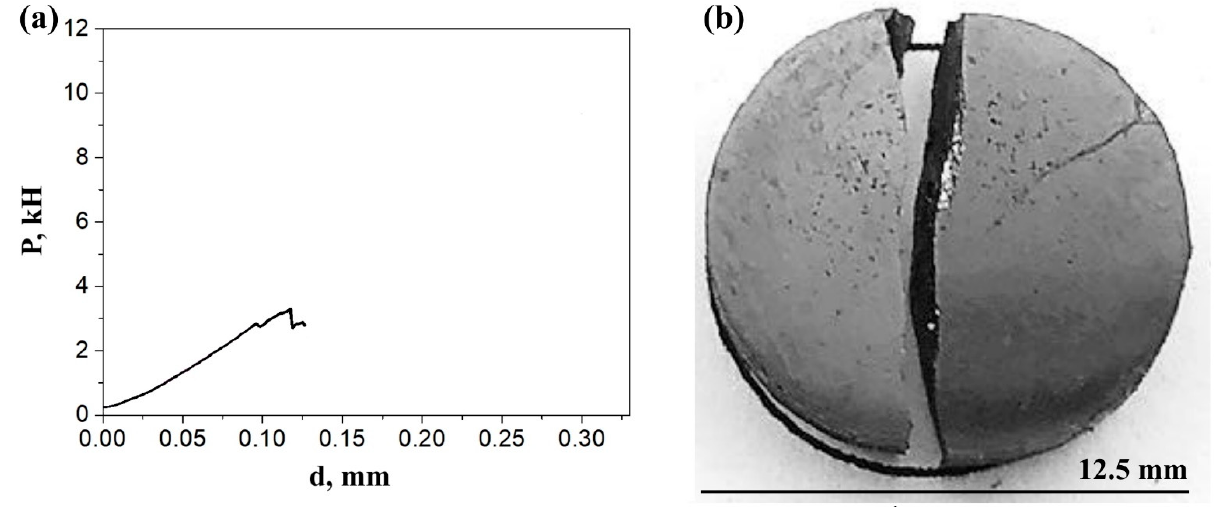
Figure 3. ( a ) The dependence of the change in the loading force on the AlMgB 14 sample, obtained from the displacement during the experiment for the Brazilian test at a temperature of 24 °C and a loading speed of 0.75 mm/min; ( b ) the appearance of the AlMgB 14 sample, fractured after the Bra- zilian test; ( c ) macro- and ( d ) micro-images of the fracture surface of the AlMgB 14 sample. 4. Discussion The appearance of the AlMgB 14 sample, fractured after the Brazilian test, is shown in Figure 3b. Analyzing the image of a fractured AlMgB 14 sample after the Brazilian test, we observe that the fracture is characterized by a single straight tensile crack that splits the specimen along the compression line into two halves. This failure is considered typical for loading conditions in the Brazilian test in terms of analytical strength theory assumptions [33–35]. At the same time, in [36,37], the fracture of ceramic materials after the Brazilian test was accompanied by a ternary fracture and multiple branching cracks. Such a fracture pattern can be explained by the inhomogeneous phase composition, which leads to dis- persion strengthening due to inclusions with mechanical characteristics that differ from the base material. Thus, the AlMgB 14 -based material obtained in this study has a homoge- neous phase composition, and therefore the fracture is characterized by a single straight crack. The SEM image of the fracture surface of the AlMgB 14 sample and the integrated ele- mental analysis of a typical microsection on the fracture surface are shown in Figure 3c,d.